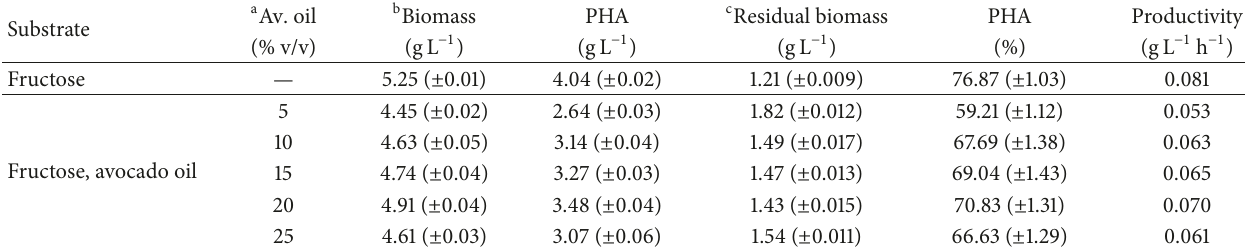
Table 1: Final yields of poly-R-hydroxyalkanoates obtained from a three-stage fermentation of Cupriavidus necator . Substrate